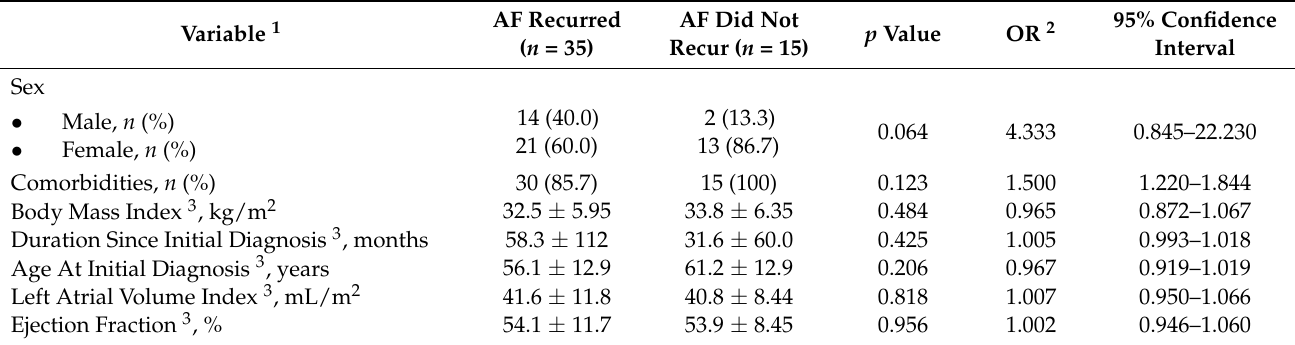
Table 4. Characterization of patients from DCC follow-up for whom AF recurred vs. did not recur with transthoracic echocardiography